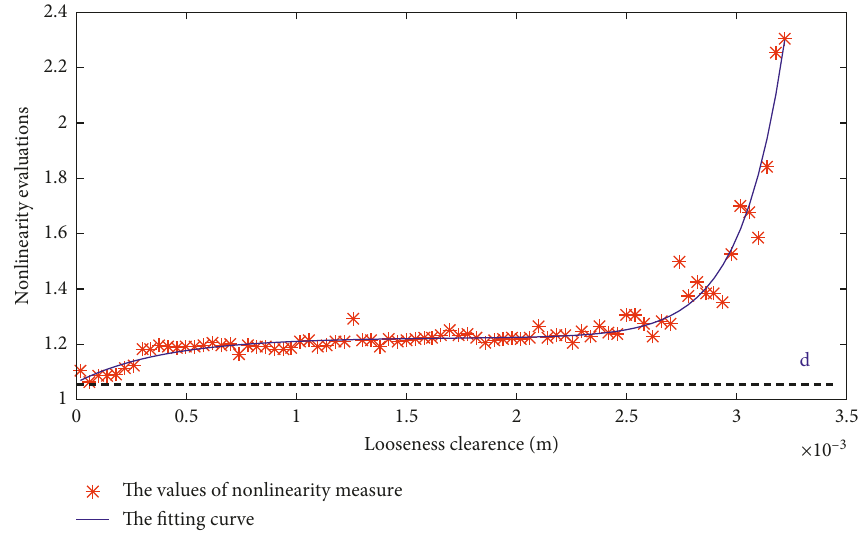
Figure 14: The relationship of results of nonlinearity measure and looseness clearances.